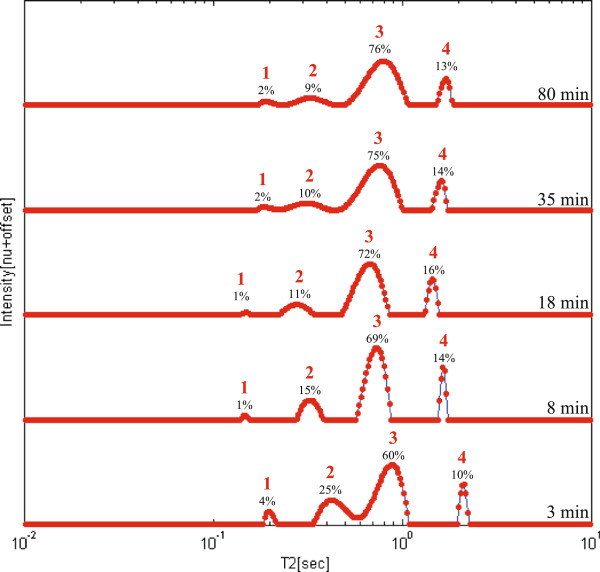
At-line monitoring of the TE reaction using relaxation time distribution experiments. Monitoring is shown using the combined 1D continuous distribution of exponentials of five samples acquired at different times in the course of the TE reaction of rapeseed oil into biodiesel. Samples were analyzed using PDCO. The content of each component, in relation to other components in the mixture, is shown on each relaxation time distribution.